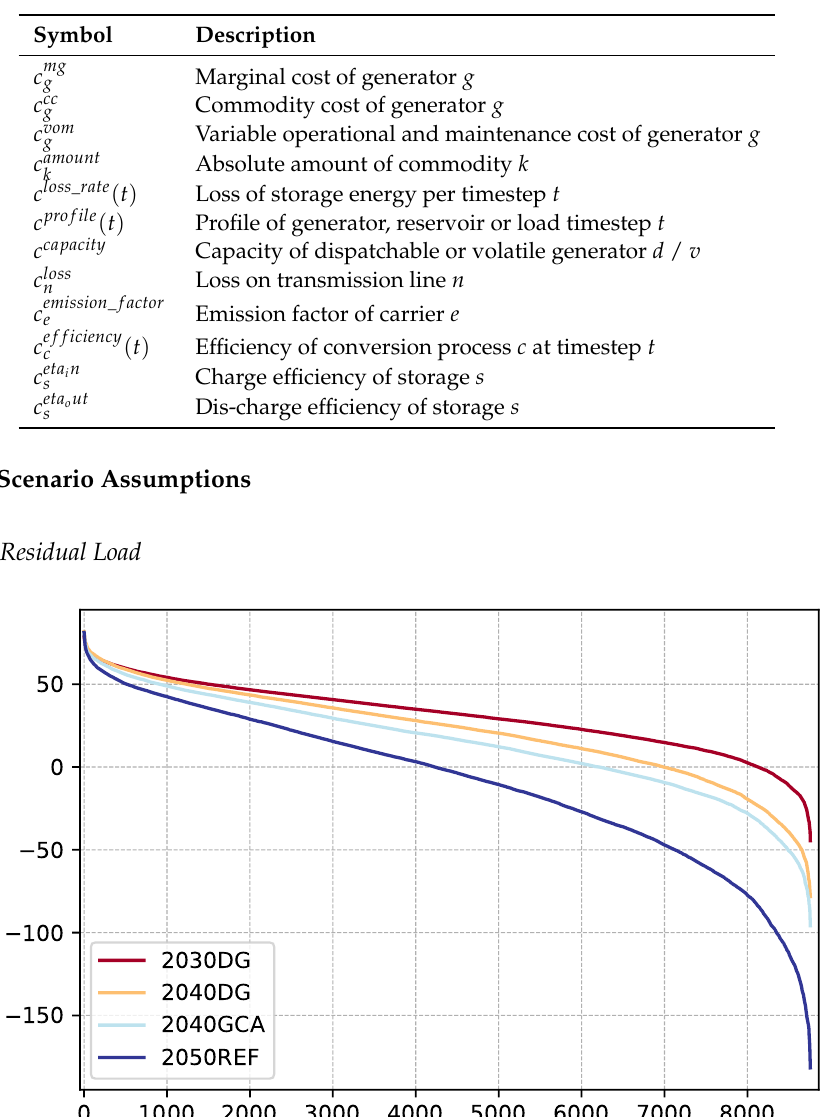
Table A3. List of parameters in the model.